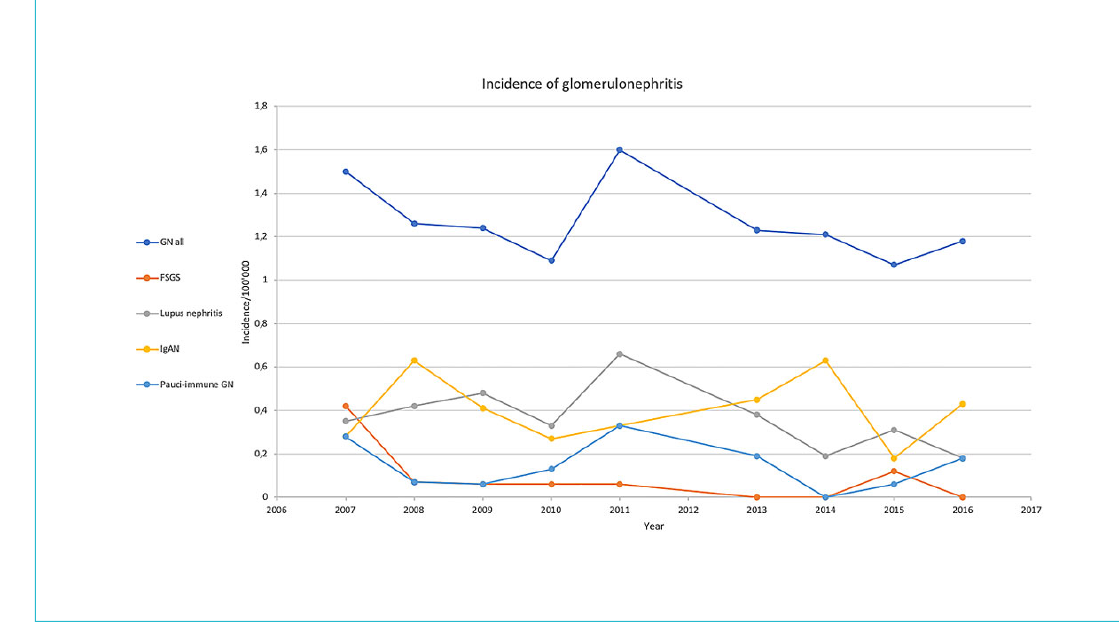
Figure 2: Evolution of the local incidence of glomerulonephritis over time: all causes combined as well as the most frequent forms of primary glomerulonephritis. FSGS = focal segmental glomerulosclerosis; GN = glomerulonephritis; IgAN = IgA